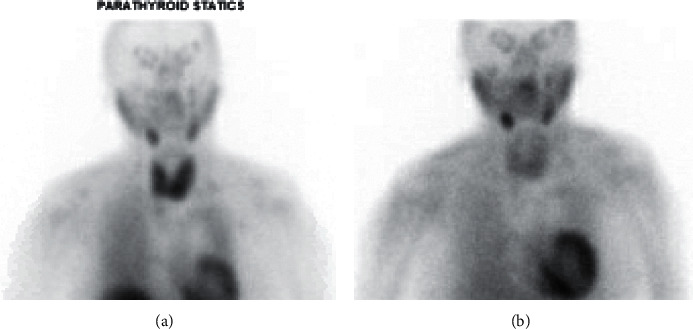

99m-STS with a dose of 19.43 mCi showed an intense initial intense uptake of the tracer activity within both thyroid lobes (a) followed by a complete washout in the 2-hour delayed images (b) suggestive of AIT-1.